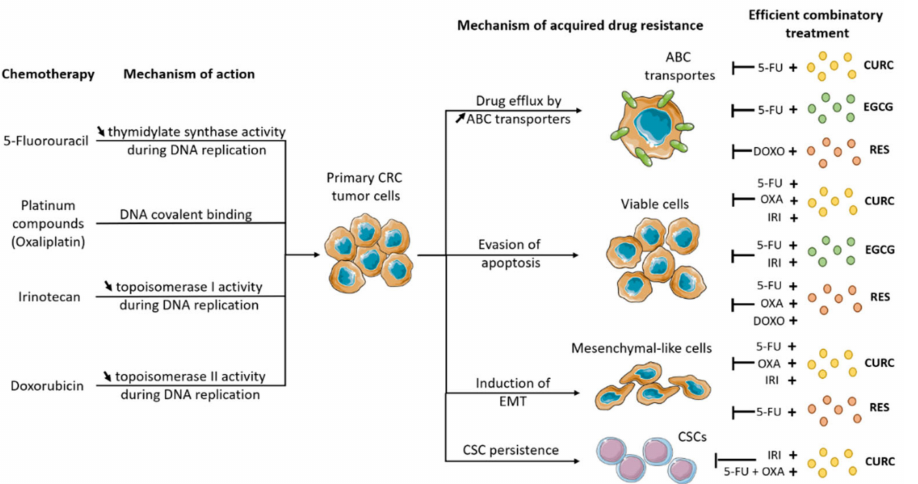
Figure 1. Combinatory therapeutic strategies involving a systemic chemotherapeutic drug and a plant-derived compound that proved their efficiency in reversing the acquired drug resistance in